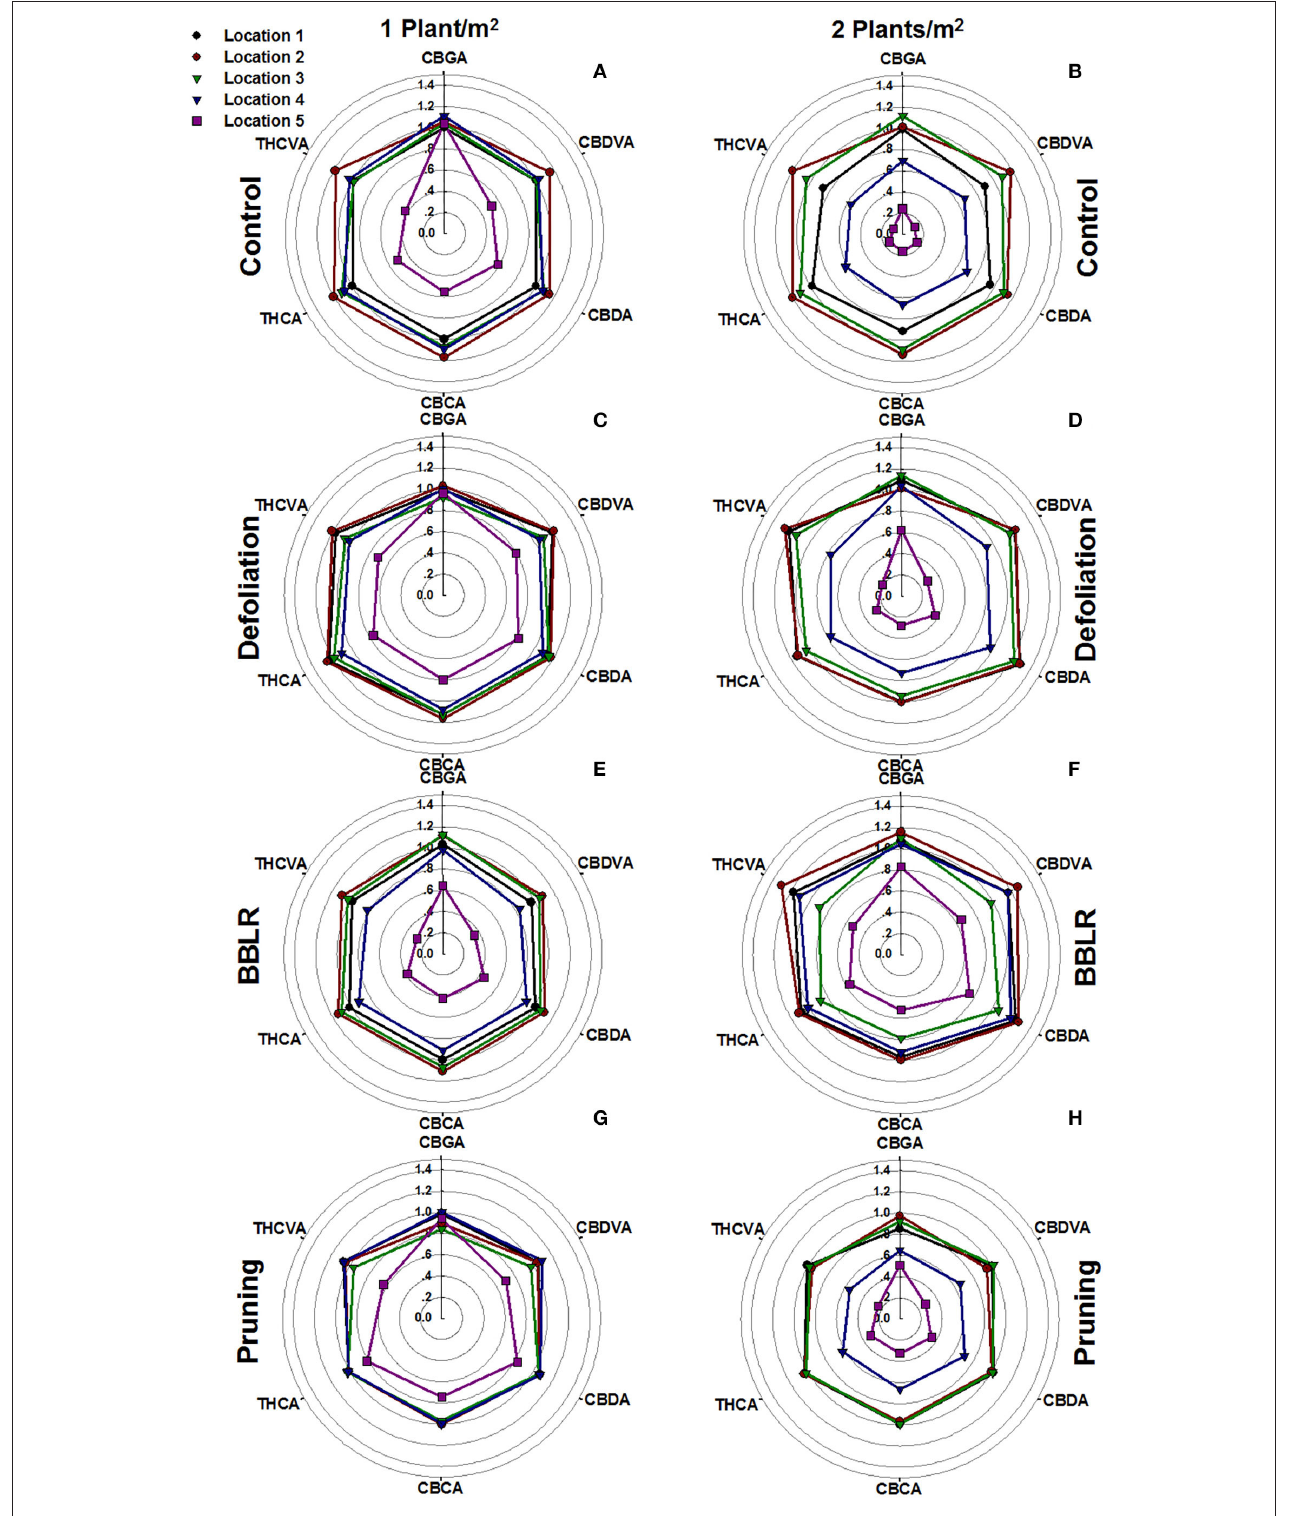
FIGURE 5 | Effect of plant density and plant architecture treatments on cannabinoid concentrations in inflorescences from five locations in the plant. The data presented are concentration of each cannabinoid, relative to its concentration in the apical inflorescence of the main stem of the “Control” at the 1 plant/m 2 treatment (location1). 1 plant/m 2 density (A,C,E,G) , 2 plants/m 2 density (B,D,F,H) . Architecture manipulation treatments: “Control” (A,B) , “Defoliation” (C,D) , Removal of leaves and branches from the bottom part of the plant [“BBLR”] (E,F) and “Pruning” (G,H) . The results are mean ( n = 6).